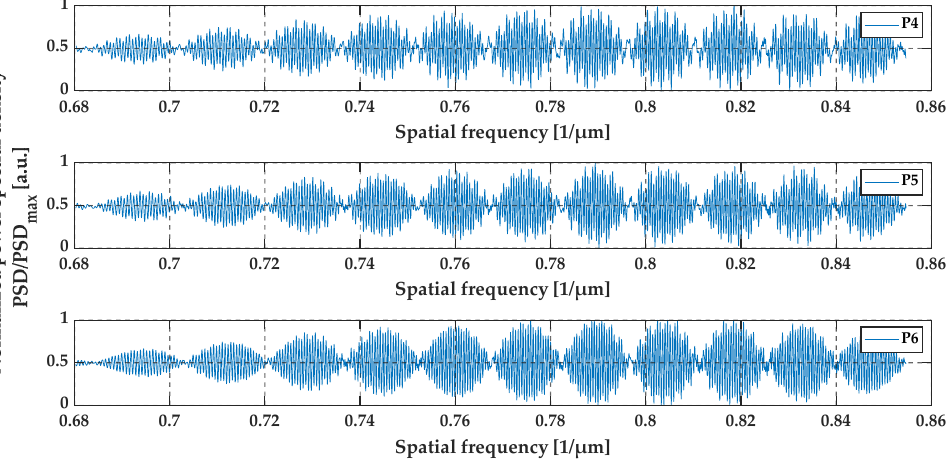
Figure 18. The preprocessed data at positions P4, P5, and P6.